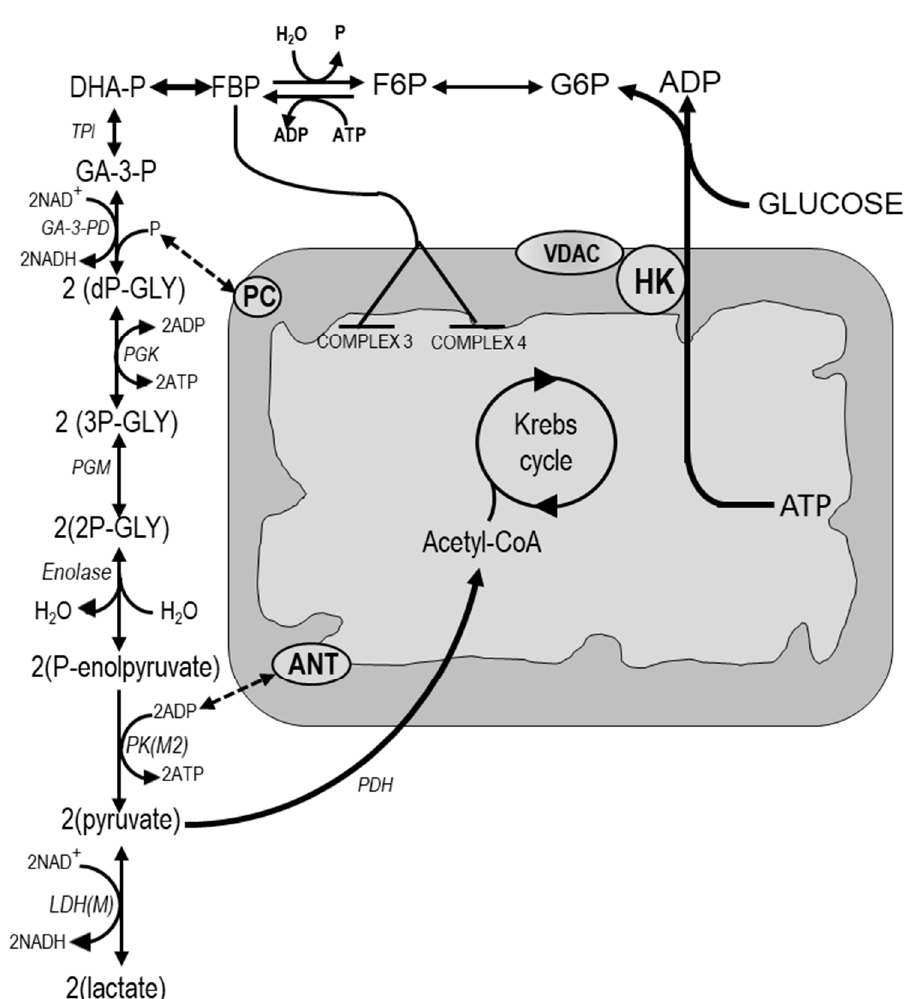
Figure 2. Reciprocal regulation between mitochondria and glycolytic pathway. Abbreviations: ANT, adenosin nucleotide transporter; PC, Pi carrier; VDAC, voltage-dependent anion channel. Substrates: DHA-P, dihydroxyacetone phosphate; F6P, fructose-6-phosphate; FBP, fructose-1,6-biphosphate; G6P, glucose-6-phosphate; 2dP-GLY,2-diphosphoglycerate; 2PG,2-phosphoglycerate; 3PG,3-phosphoglycerate; PEP, phosphoenolpyruvate. Enzymes: GA-3-PD, glyceraldehyde-3-phosphate dehydrogenase; LDH, lactate dehydrogenase; PDH, pyruvate dehydrogenase; PGK, phosphoglycerate kinase; PGM, phosphoglycerate mutase; PKM2, pyruvate kinase M2; TPI, triose-phosphate isomerase. Dotted double arrows indicate competition.